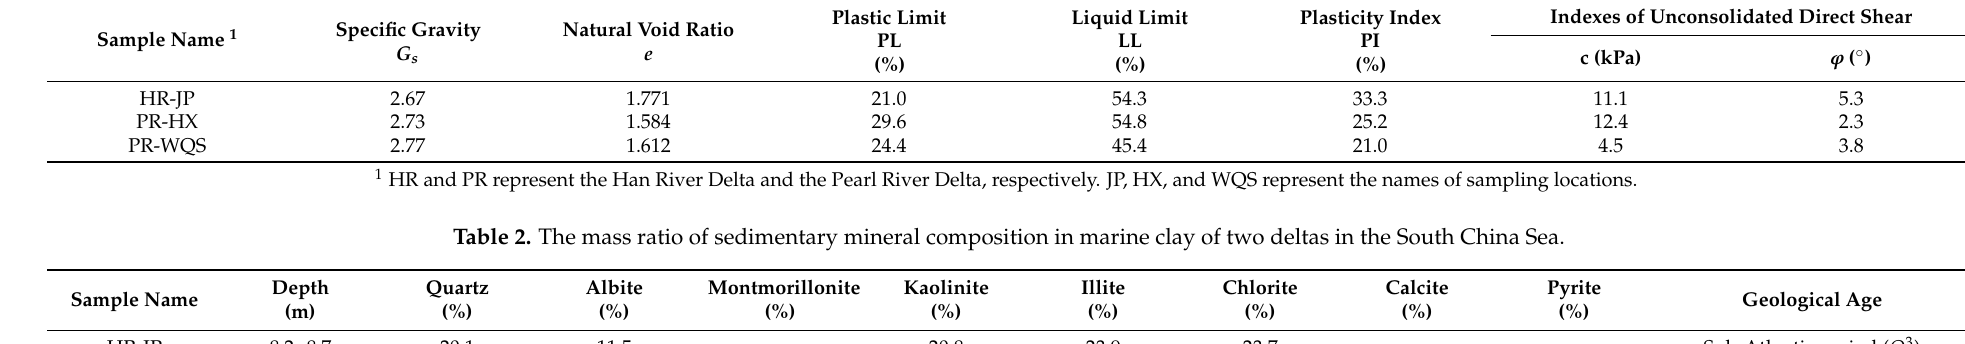
Table 1. The basic physical properties in marine clay of two deltas in the South China Sea.